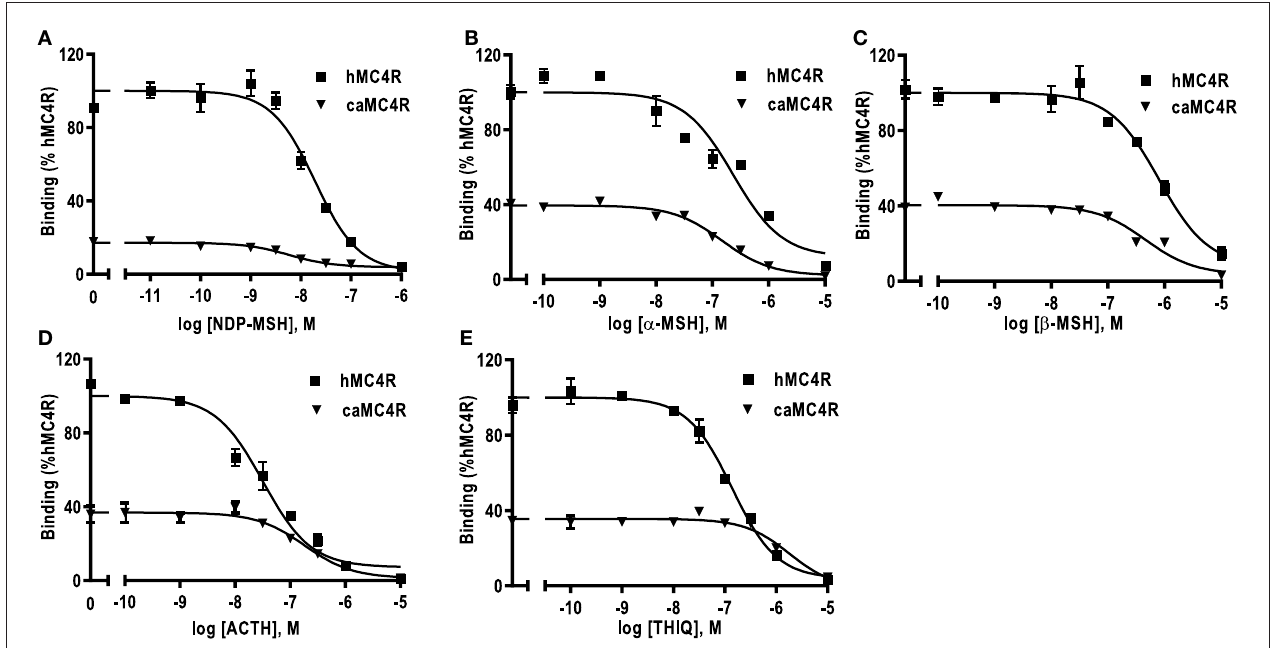
FIGURE 4 | Ligand binding properties of caMC4R. HEK293T cells were transiently transfected with caMC4R plasmids (hMC4R was used as a control). Different concentrations of unlabeled NDP-MSH (A) , α -MSH (B) , β -MSH (C) , ACTH (1–24) (D) , and THIQ (E) was used to displace the binding of 125 I-NDP-MSH. Results are expressed as % of hMC4R binding (in the absence of competitor) ± range from duplicate determinations within one experiment. All experiment was repeated at least three times independently.